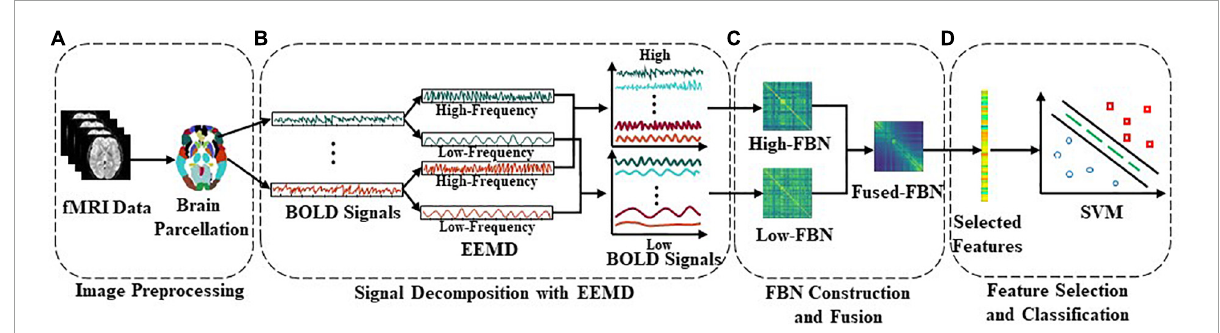
FIGURE1 Flowchart of the proposed multi-band network fusion framework (MBNF) scheme for brain disease classification, including four major parts: (A) data acquisition and image pre-processing; (B) blood oxygen level dependent (BOLD) signal decomposition based on ensemble empirical mode decomposition (EEMD); (C) functional brain networks (FBN) construction and fusion; and (D) feature selection and classification.